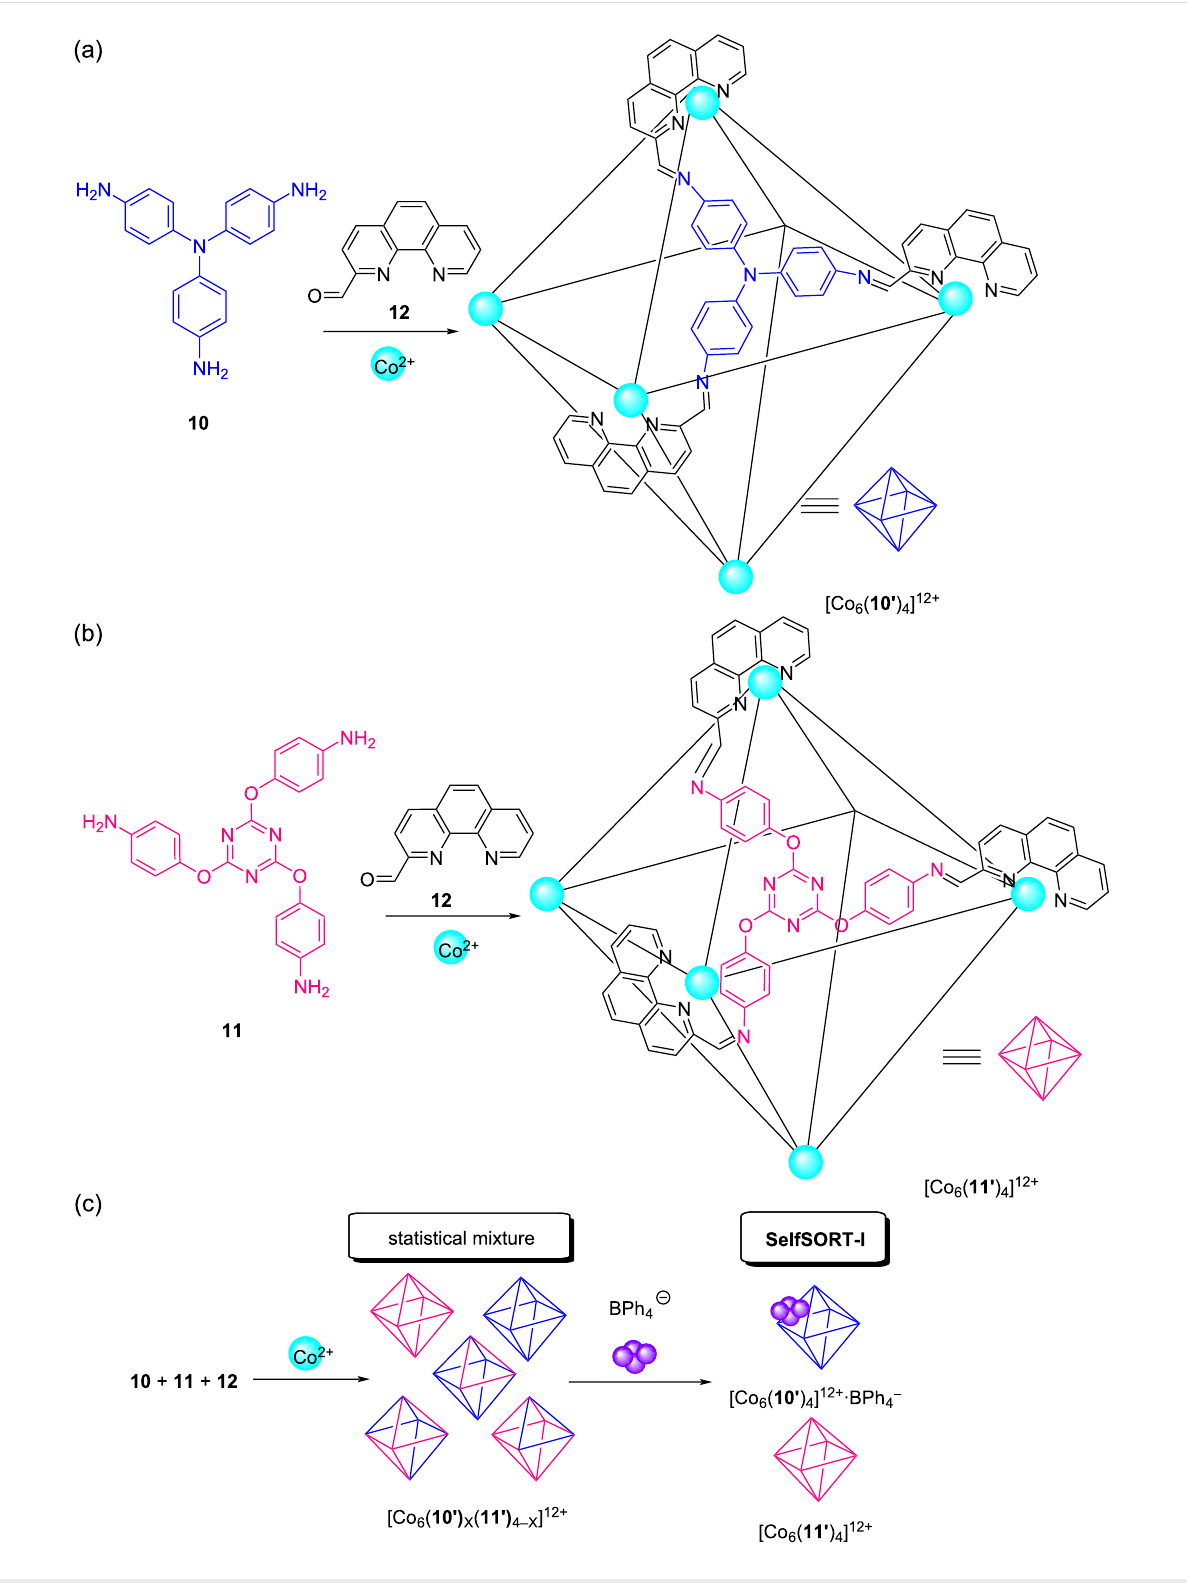
Figure 6: The formation of octahedral cages (a) [Co 6 ( 10' ) 4 ] 12+ and (b) [Co 6 ( 11' ) 4 ] 12+ . (c) The 2-fold completive self-sorting after the addition of periph- erally binding BPh 4 −